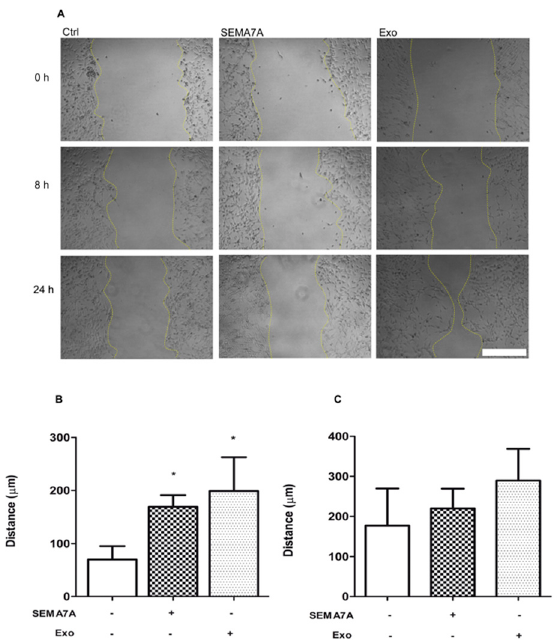
Figure 5. SEMA-7A (Semaphorin7A) and Glioma Associated Stem Cells (GASC)-derived exosomes stimulate motility of Glioma Stem Cells (GSC) cell populations. ( A ) Representative images of scratched GSC cultures untreated (Ctrl), exposed to SEMA-7A-Fc 100 ng / mL (SEMA7A) or GASC-derived exosomes (Exo) for 8 and 24 h. ( B , C ) Distance covered by cells treated as described in (A) and untreated cells (Ctrl) after 8 (B) and 24 h (C) was calculated measuring the width of the gap between the two margins of scratched monolayer. Scale bar = 200 µ m. Data are presented as means ± standard deviation of 4 replicates (* p < 0.01 vs. Ctrl). Statistical analysis was performed by repeated measurements one-way ANOVA followed by Dunn’s Multiple Comparison post-test (GraphPad Prism 5, San Diego, California).